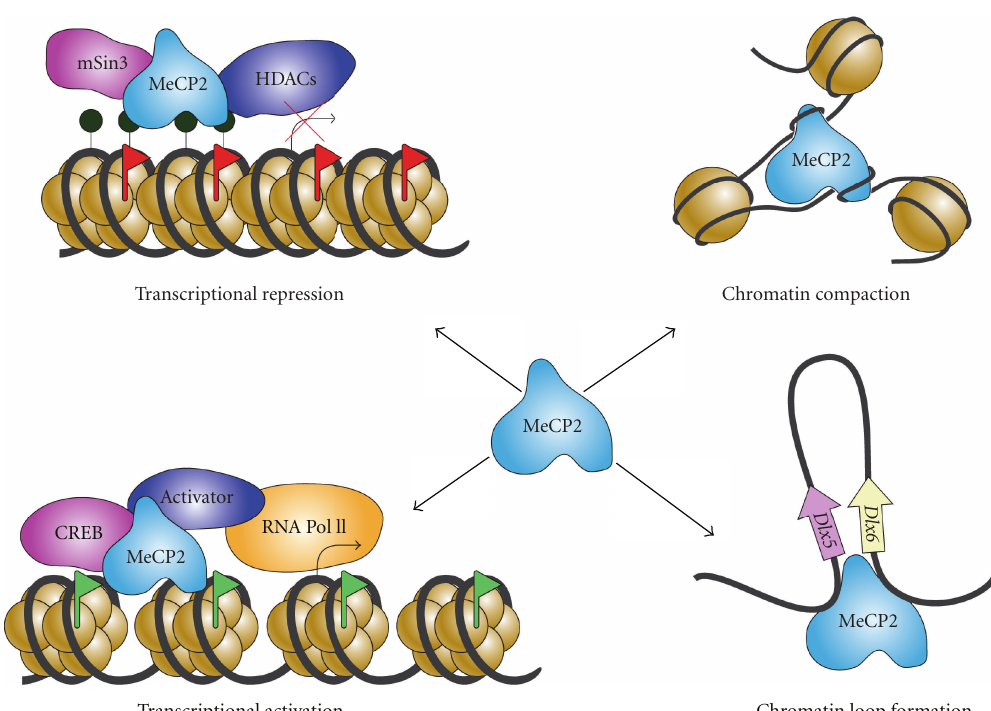
Figure 1: The diverse functions of MeCP2 in gene regulation and chromatin